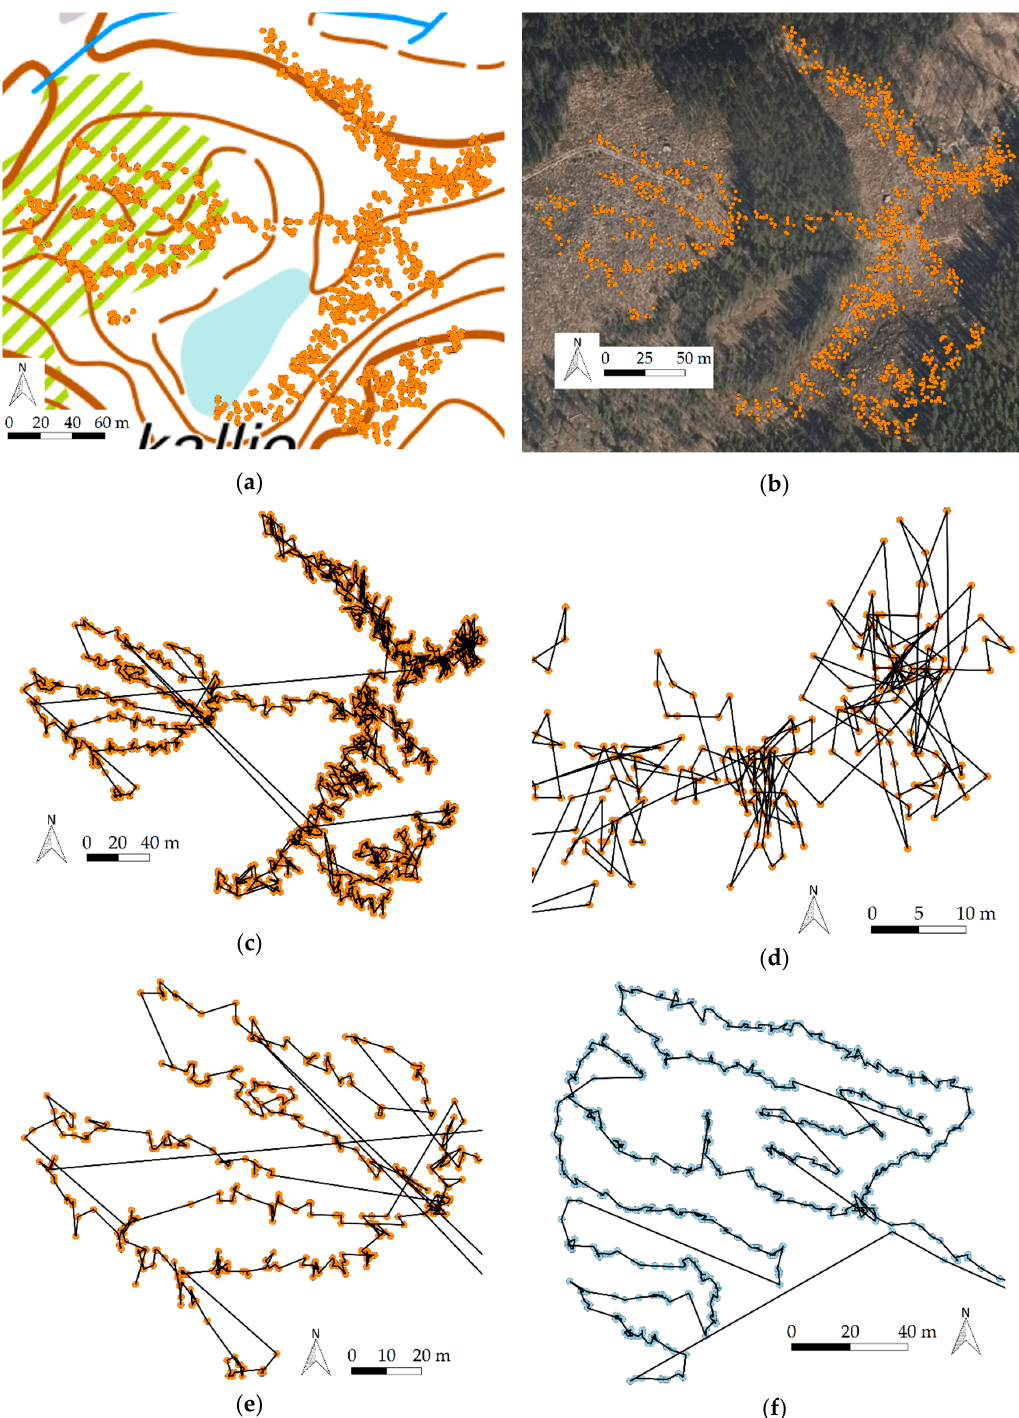
Figure A1. Location data points from two different harvesters at clear cutting objects. The line is drawn on the points of harvested object in cutting order of the trees, based on StemNumber. Note the scales of the subfigures. The ETRS-TM35FIN (EPSG:3067) coordinate system is used in the figure. ( a ) The harvested object at basemap. ( b ) The harvested object at aerial image. ( c ) The overall cutting order of one object. Harvester was known to have less accurate GNSS receiver. ( d ) At the upper right corner of Figure a, the recorded locations of consequent trees have distances of several meters, showing a presence of GNSS positioning error. ( e ) At the left part of Figure a the positioning accuracy is visually better than in Figure b. ( f ) For comparison, data of object where harvester was known to have a more accurate GNSS positioning. Basemap and aerial image © National Land Survey of